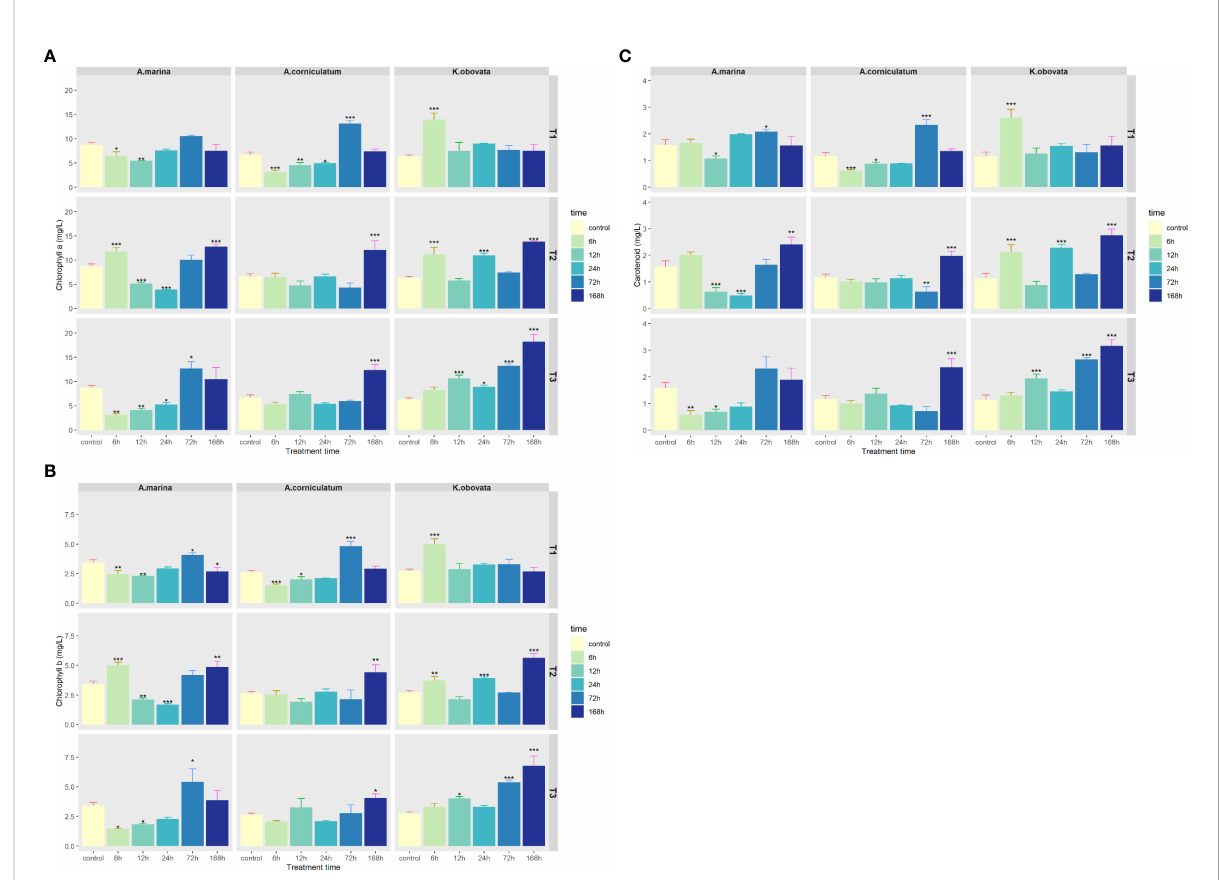
FIGURE 1 The changes of (A) Chlorophyll a, (B) Chlorophyll b and (C) Carotenoid contents under different upwelling stresses. * indicates that there are signi fi cant differences between control and treatment groups (p<0.05(*), p<0.01(**), p<0.001(***)). “ T1 ” means 5°C upwelling stress, “ T2 ”